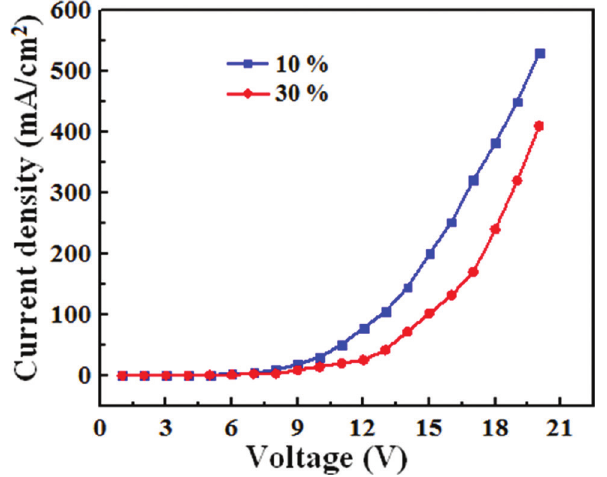
Figure 10: Current density (J)–voltage (V) characteristics of prepared OLED